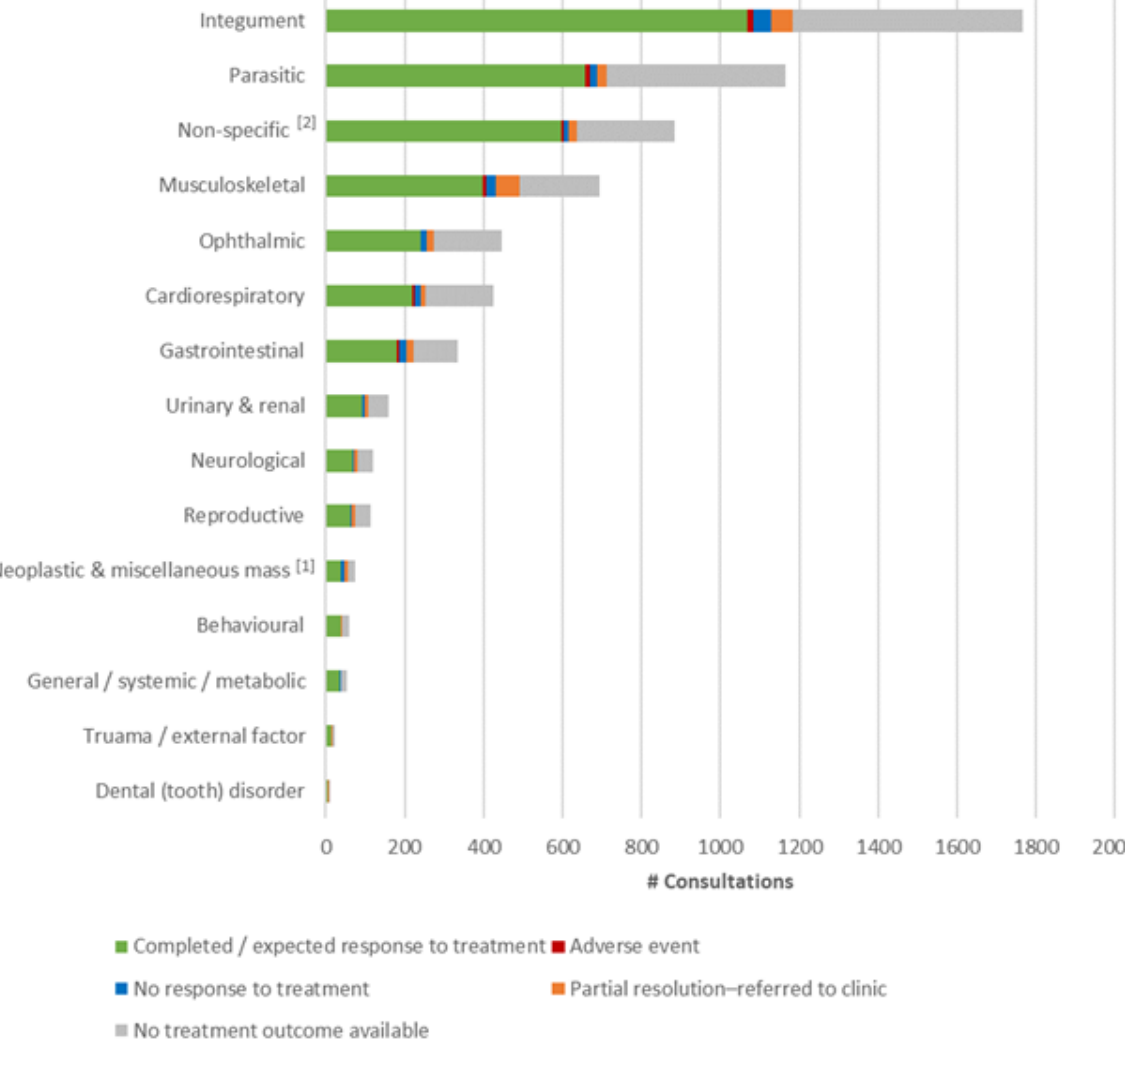
Figure 7: Patient outcomes for consultations with remote POM-V / POM prescriptions for the audit period grouped by body system / disease